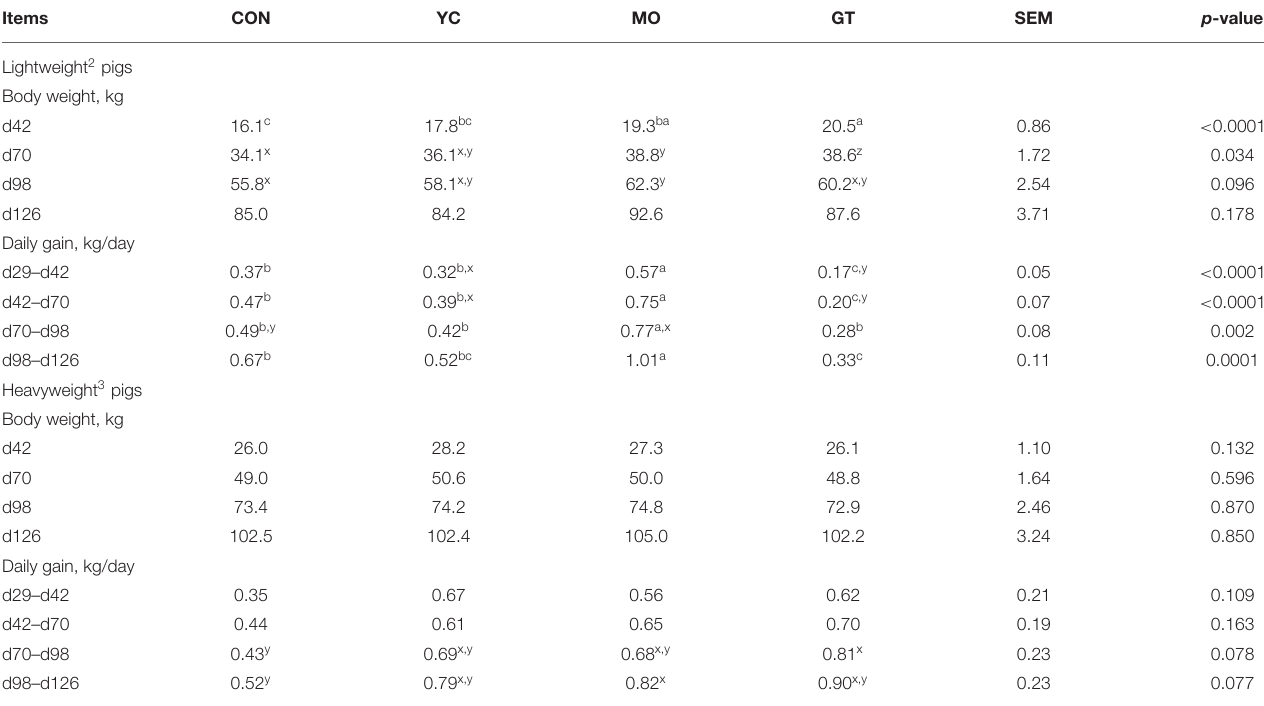
TABLE 8 | Grow-finish (d29–d126 after weaning) performance of offspring deemed light and heavy at weaning from sows provided feed additives during gestation and lactation and weaned to the on-site facility (study 2) 1,4,5 . Items CON YC MO GT SEM p